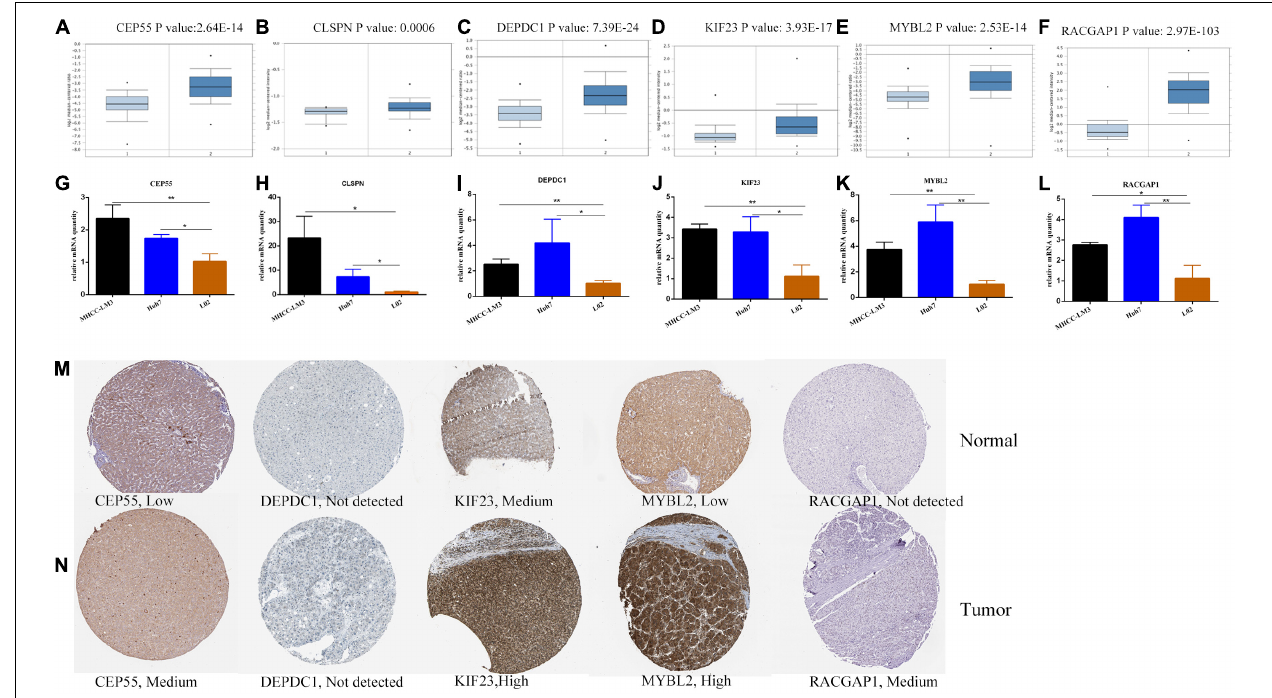
FIGURE 7 | The transcriptional expression of six hub genes in HCC (right panels) and normal liver samples (left panels) based on Oncomine database (A–F) . The relative mRNA expression of six hub genes in HCC cell lines and liver cell line (G–L). * P < 0.05, ** P < 0.01. The protein expression of hub genes based on Human Protein Atlas database (M–N). The protein expressed level of DEPDC1 was not detected in both tumor and normal liver tissues and the expressed data of CLSPN was lacking in